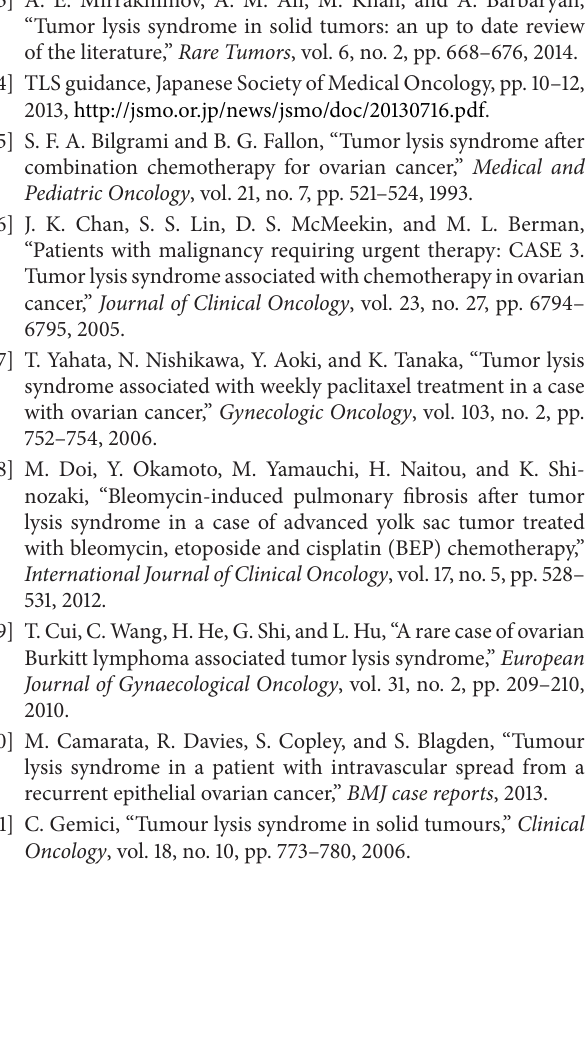
Table 1: Patient’s laboratory data on